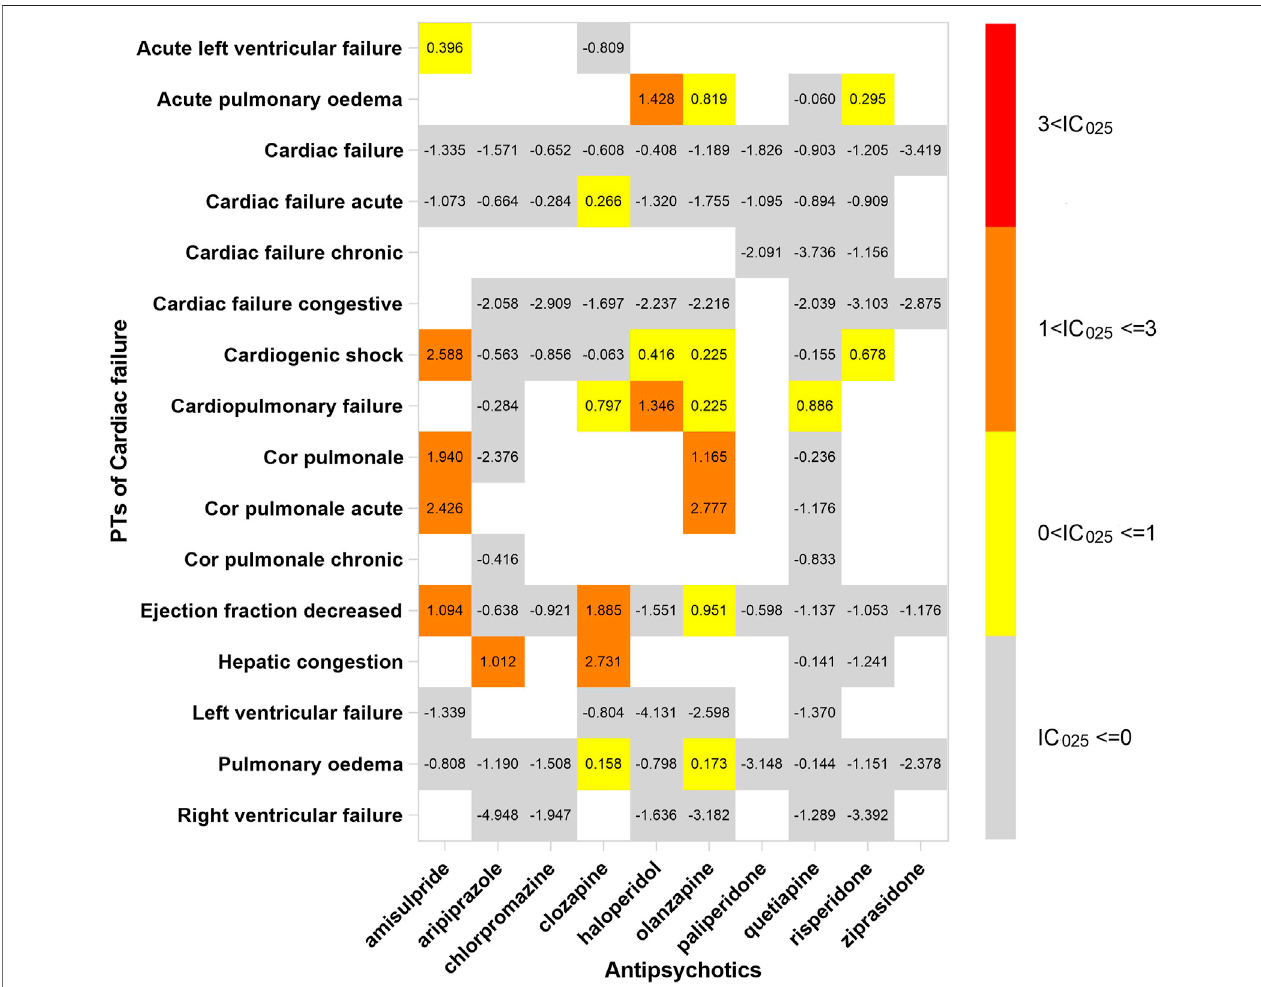
FIGURE 3 | The spectrum of cardiac failure induced by various APs. PT: preferred term; IC 025 : the lower end of the 95% con fi dence interval of the information component.The numbers inblocksrepresentthevalue ofIC 025 ofeach combinationoftarget antipsychotic andPT. Ejection fraction decreased isthecommon PTboth in cardiac failure and in